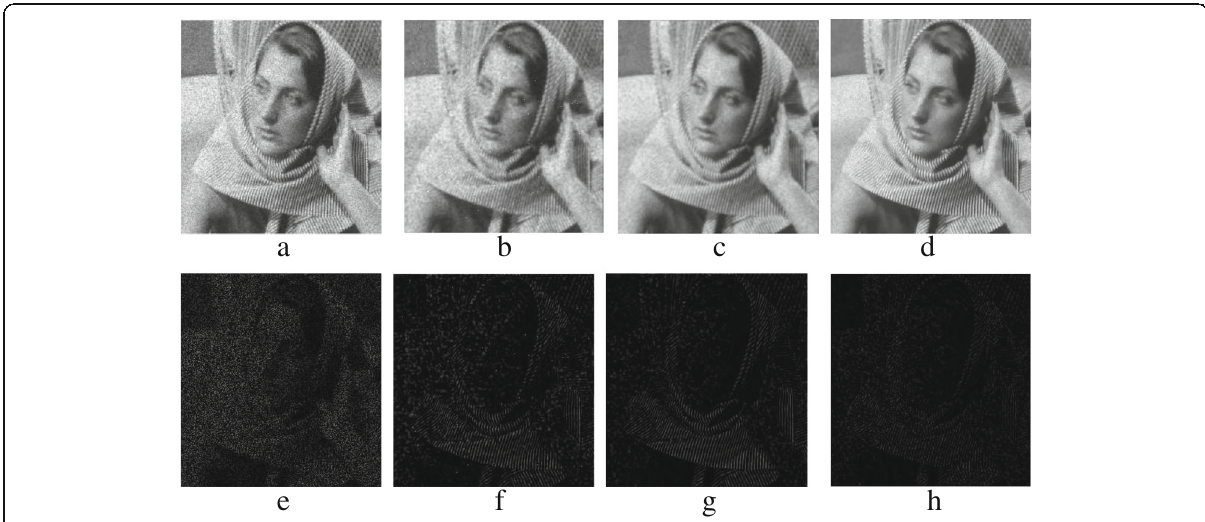
Fig. 5 Zoomed version of the denoised image Woman of different methods degraded by a Gamma noise with variance 0.02. a Noisy image, b nonlocal-AA method, c nonlocal-SO method, d proposed method, e noise image, f method noise image of nonlocal-AA method, g method noise image of nonlocal-SO method, and h method noise image of proposed